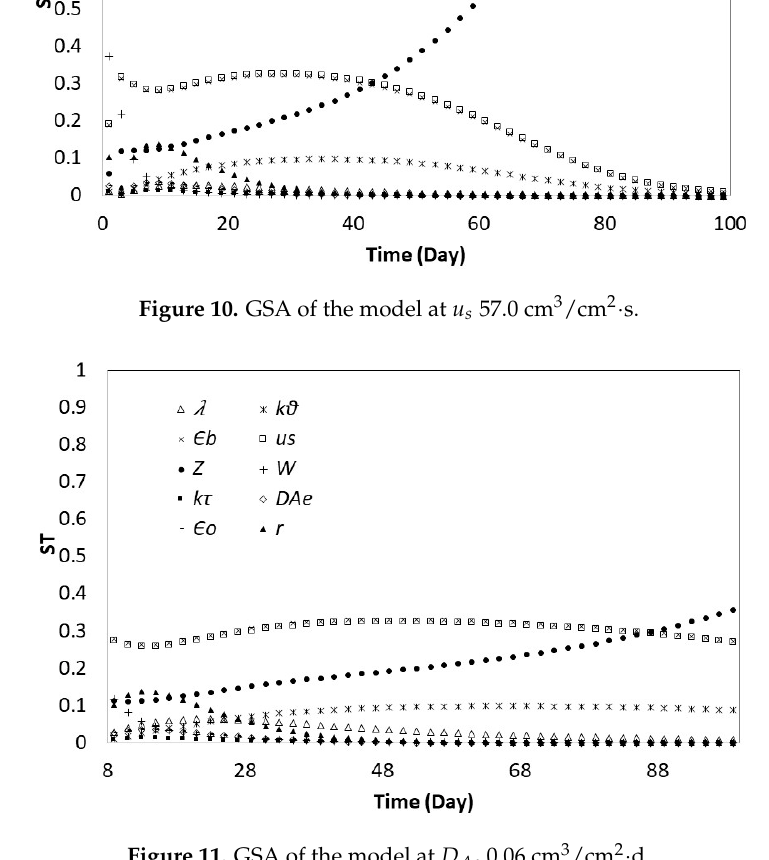
Figure 12. GSA of the model at (cid:1830) (cid:3002)(cid:3032) 0.112 cm 3 /cm 2 ·d.